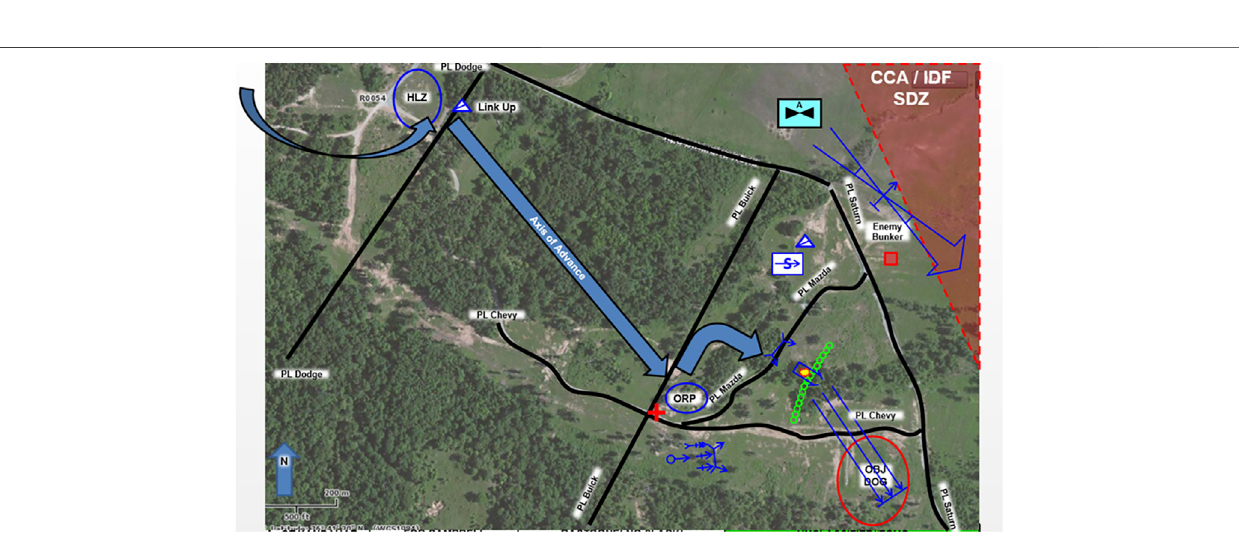
FIGURE 3 | Sample scenario of an operational